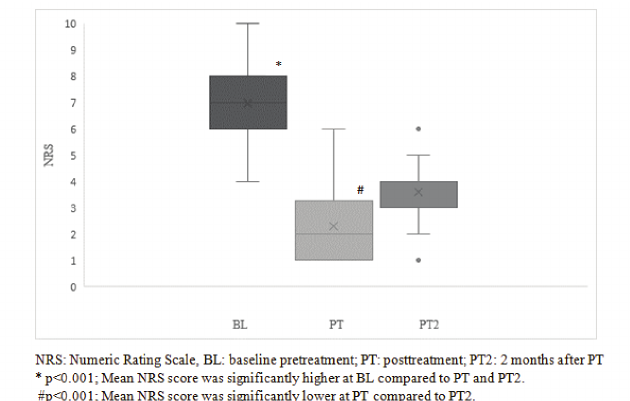
Figure 5 - AROM values of the patients at BL, PT, and